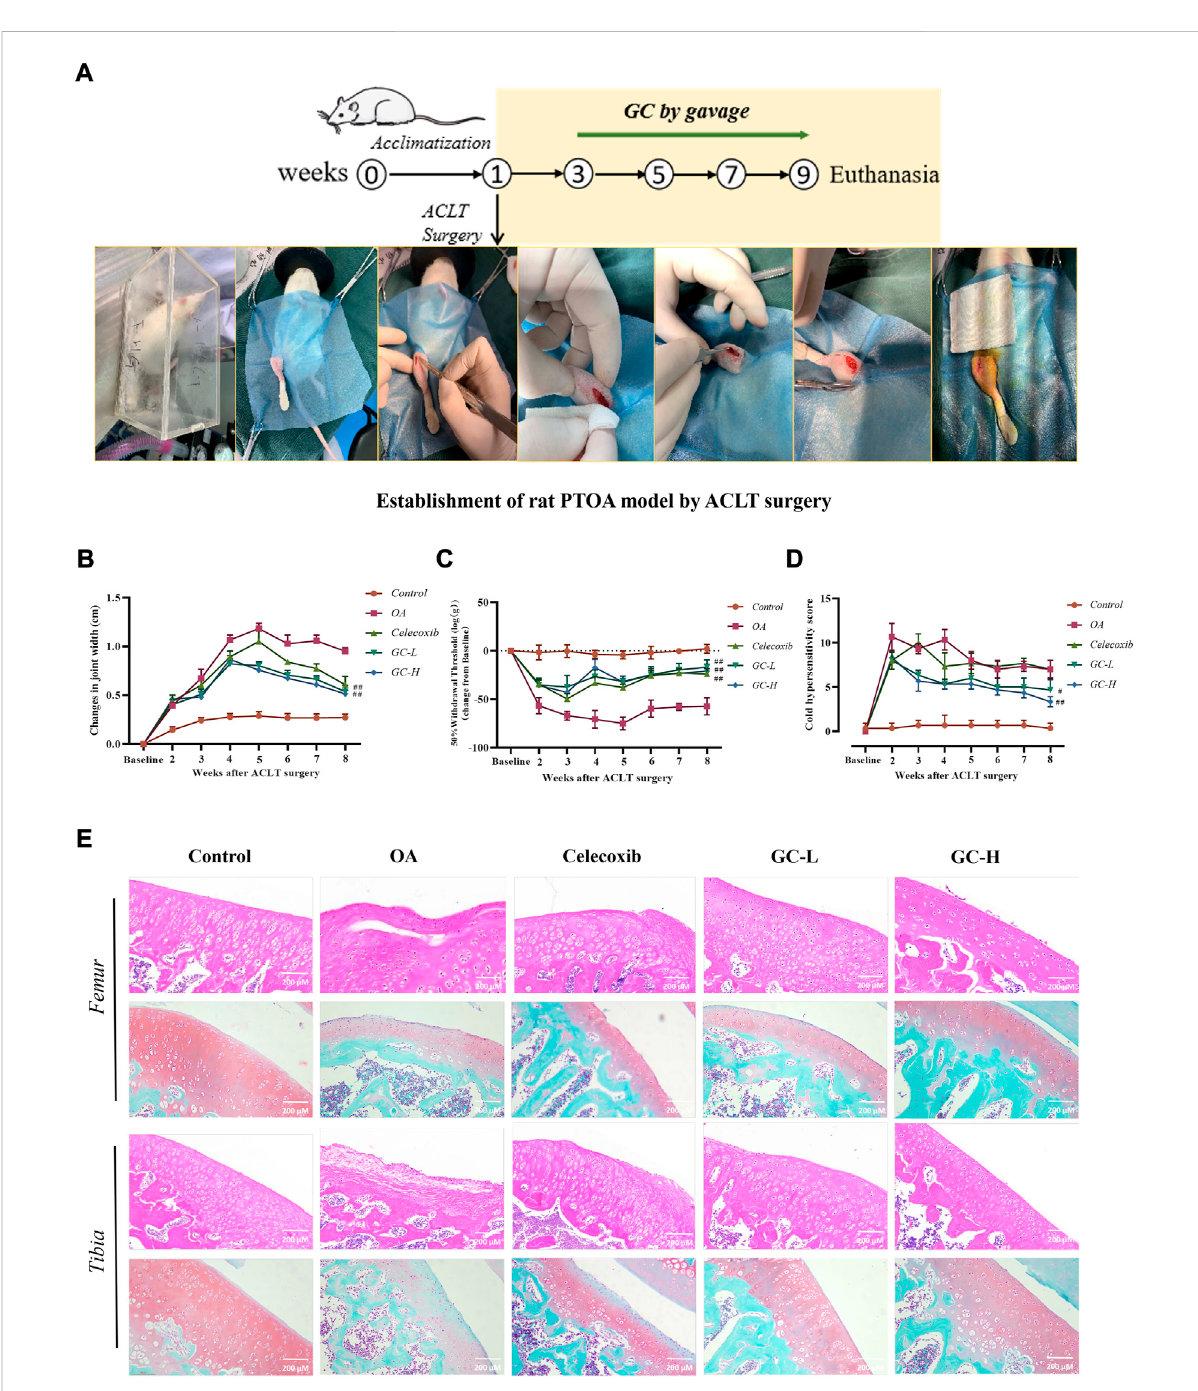
FIGURE 5 GC attenuates the severity of joint pain and cartilage degeneration in ACLT rats. (A) Schematic of the dosing time-course of the rat anterior cruciate ligament transection (ACLT)-induced knee OA model. (B) Knee width Measurement. (C) Mechanical sensitivity. (D) Cold hypersensitivity. (E) Representative images of the knee joint stained with hematoxylin-eosin (HE) and Saffron O Fast Green (SO-FG). 200 µm scale bar. All data are presented as mean ± SD (n = 3). * p < 0.05 and ** p < 0.01 vs. control group; # p < 0.05 and ## p < 0.01 vs. OA